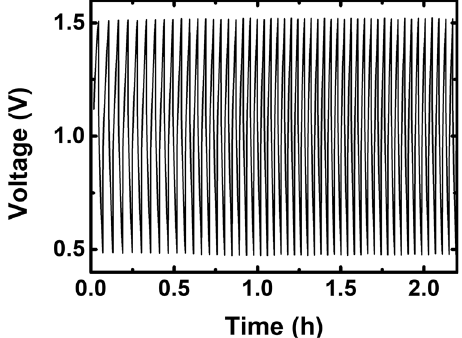
Fig. 10 Charge – discharge curves vs. time. Galvanostatic charge – discharge curves of neutral pH aqueous all-organic active materials for RFB single cell using 0.1 M of TRYP-SO 3 H as anolyte and 0.1 M of BQDS as catholyte in 1.0 M KCl solution as supporting electrolyte measured during 50